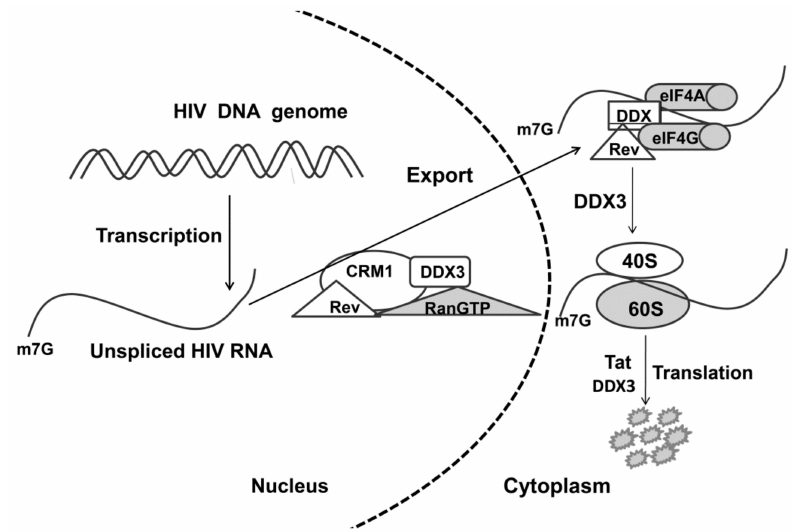
Figure 3. Hypothetical mechanism of involvement of the DDX3 helicase in the export of unspliced / partially spliced HIV RNA from nucleus to cytoplasm. CRM1—cellular export shuttle protein; Rev—shuttle protein with nuclear localization signal and a nuclear export signal. RANGTP—GTPase, Tat—HIV translation